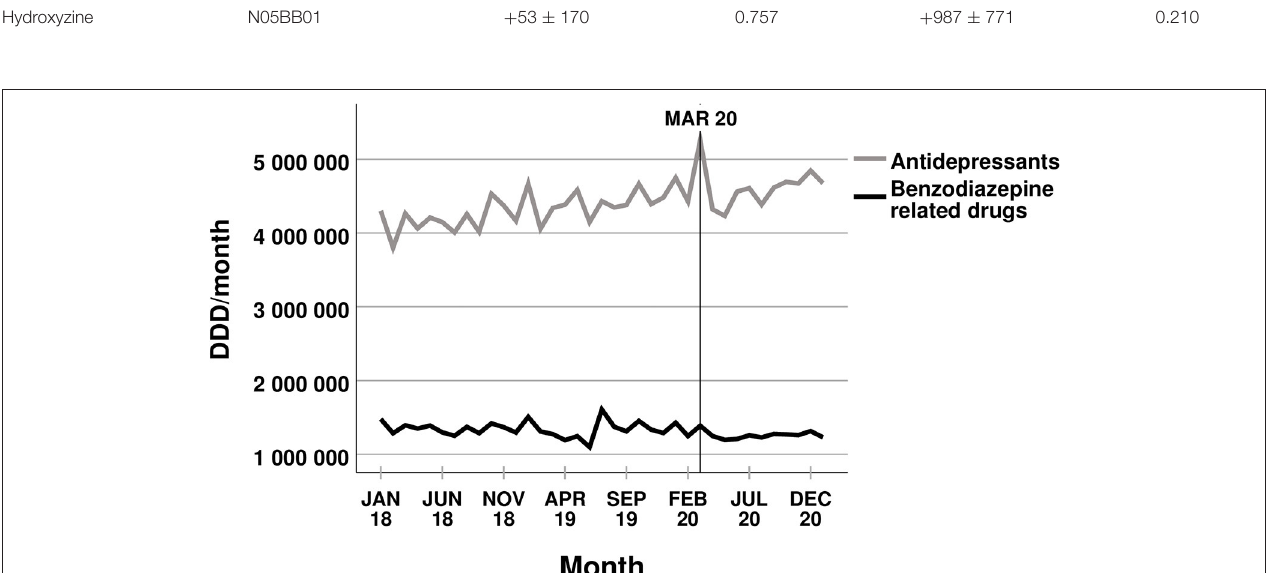
FIGURE 1 | Dispensed amounts of antidepressants and benzodiazepine related